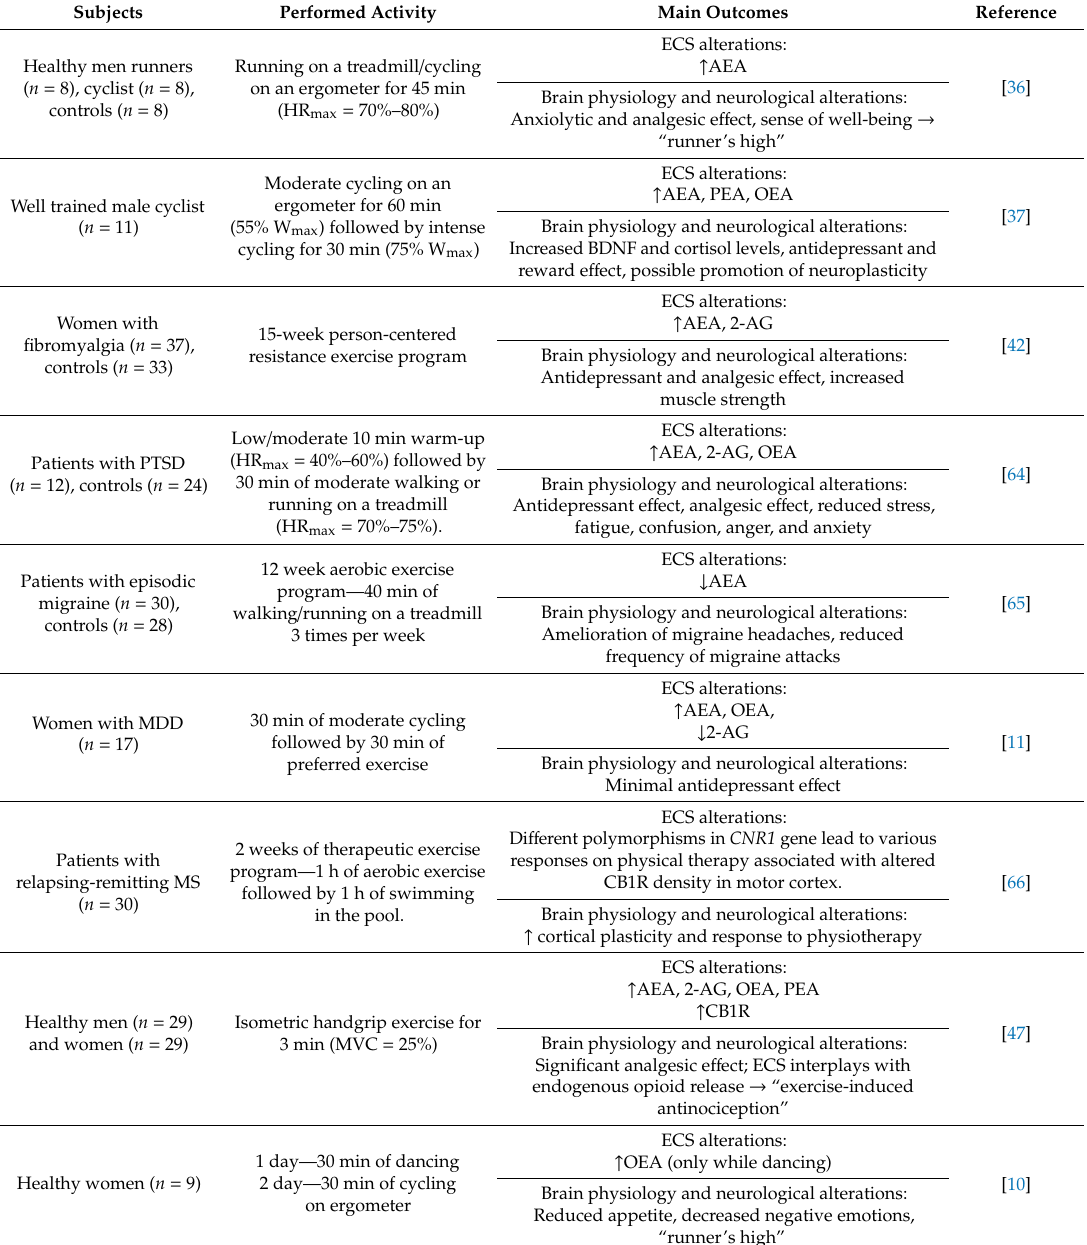
Table 1. A summary of studies analyzing the correlation between physical activity, the ECS, and possible positive outcomes on brain physiology and various neurological